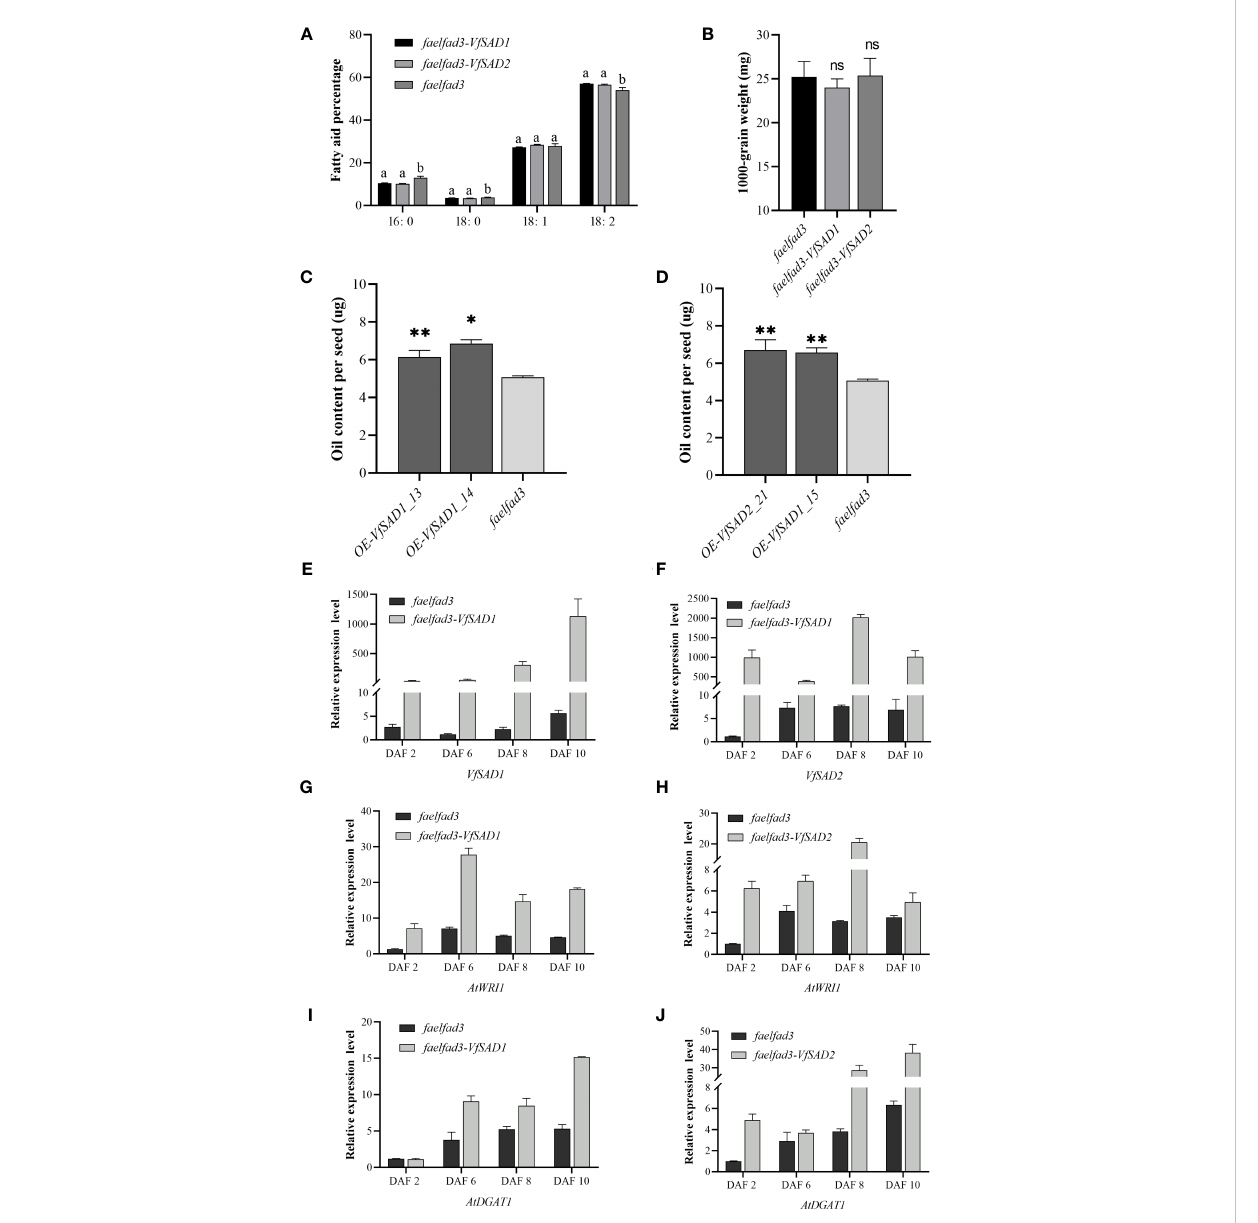
FIGURE 4 The overexpression of VfSAD1/2 altered the percentage of fatty acid components and oil content in the seeds of Arabidopsis . (A) Fatty acid composition in seeds of SAD1-OE line, SAD2-OE line, and fad3fae1 line. (B) The 1,000-grain weight in seeds of SAD1-OE line, SAD2-OE line, and fad3fae1 line. (C) Oil content in seeds of SAD1 -OE lines and fad3fae1 line. (D) Oil content in seeds of SAD2 -OE lines and fad3fae1 line. (E) The expression pattern of VfSAD1 in the SAD1-OE line and fad3fae1 line. (F) The expression pattern of VfSAD2 in the SAD2-OE line and fad3fae1 line. (G) The expression pattern of AtWRI1 in the SAD1-OE line and fad3fae1 line. (H) The expression pattern of AtWRI1 in the SAD2-OE line and fad3fae1 line. (I) The expression pattern of AtDGAT1 in the SAD1-OE line and fad3fae1 line. (J) The expression pattern of AtDGAT1 in the SAD2-OE line and fad3fae1 line. The error bar represents the standard deviation (± SD) for setting three biological replicates. Signi fi cant difference was detected by t - test (* indicates p < 0.05; ** indicates p < 0.01). A comparison between groups was conducted by one-way ANOVA test (FA component), and the different letters above the bar chart indicate signi fi cant differences ( p <